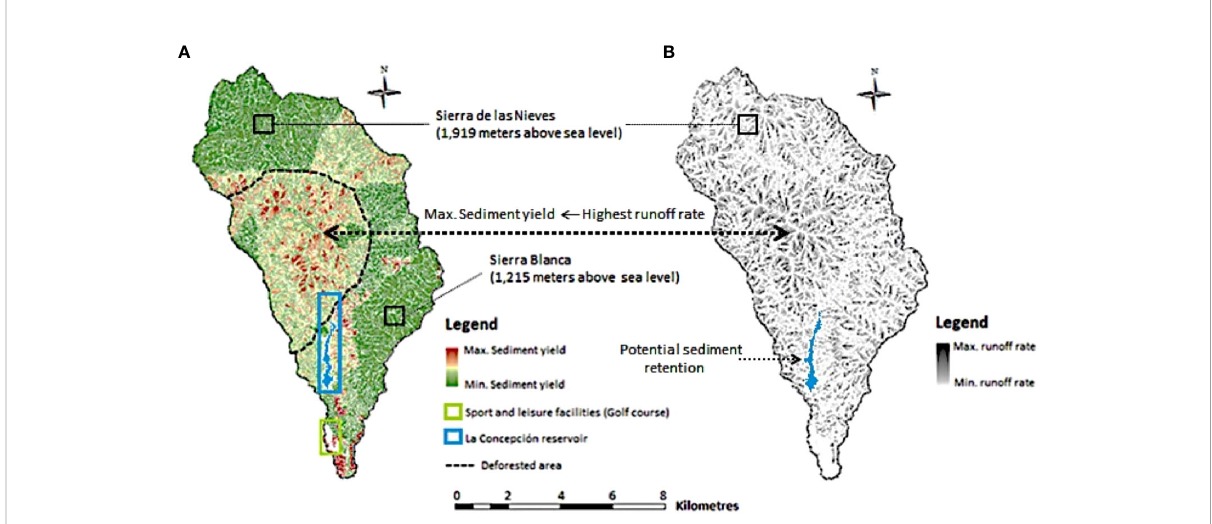
FIGURE 8 Spatial distribution of sediment yield and runoff rate in the river Verde basin. (A) Most erosive areas were predicted in the river Verde basin using the M-USLE. Deforested areas during the nineteenth century were outlined through a dashed line in black according to [18]. (B) Areas of the river Verde basin where the highest runoff rates (darker areas) would be registered according to the predictions obtained by using the